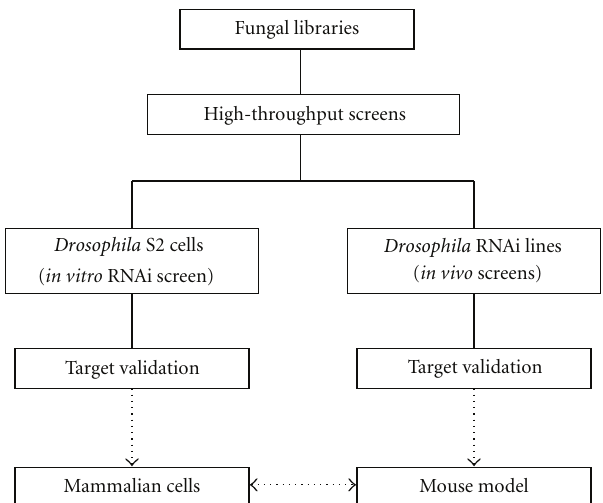
Figure 1: Prioritizing use of Drosophila model in selection of novel determinants of fungal pathogenicity in humans.